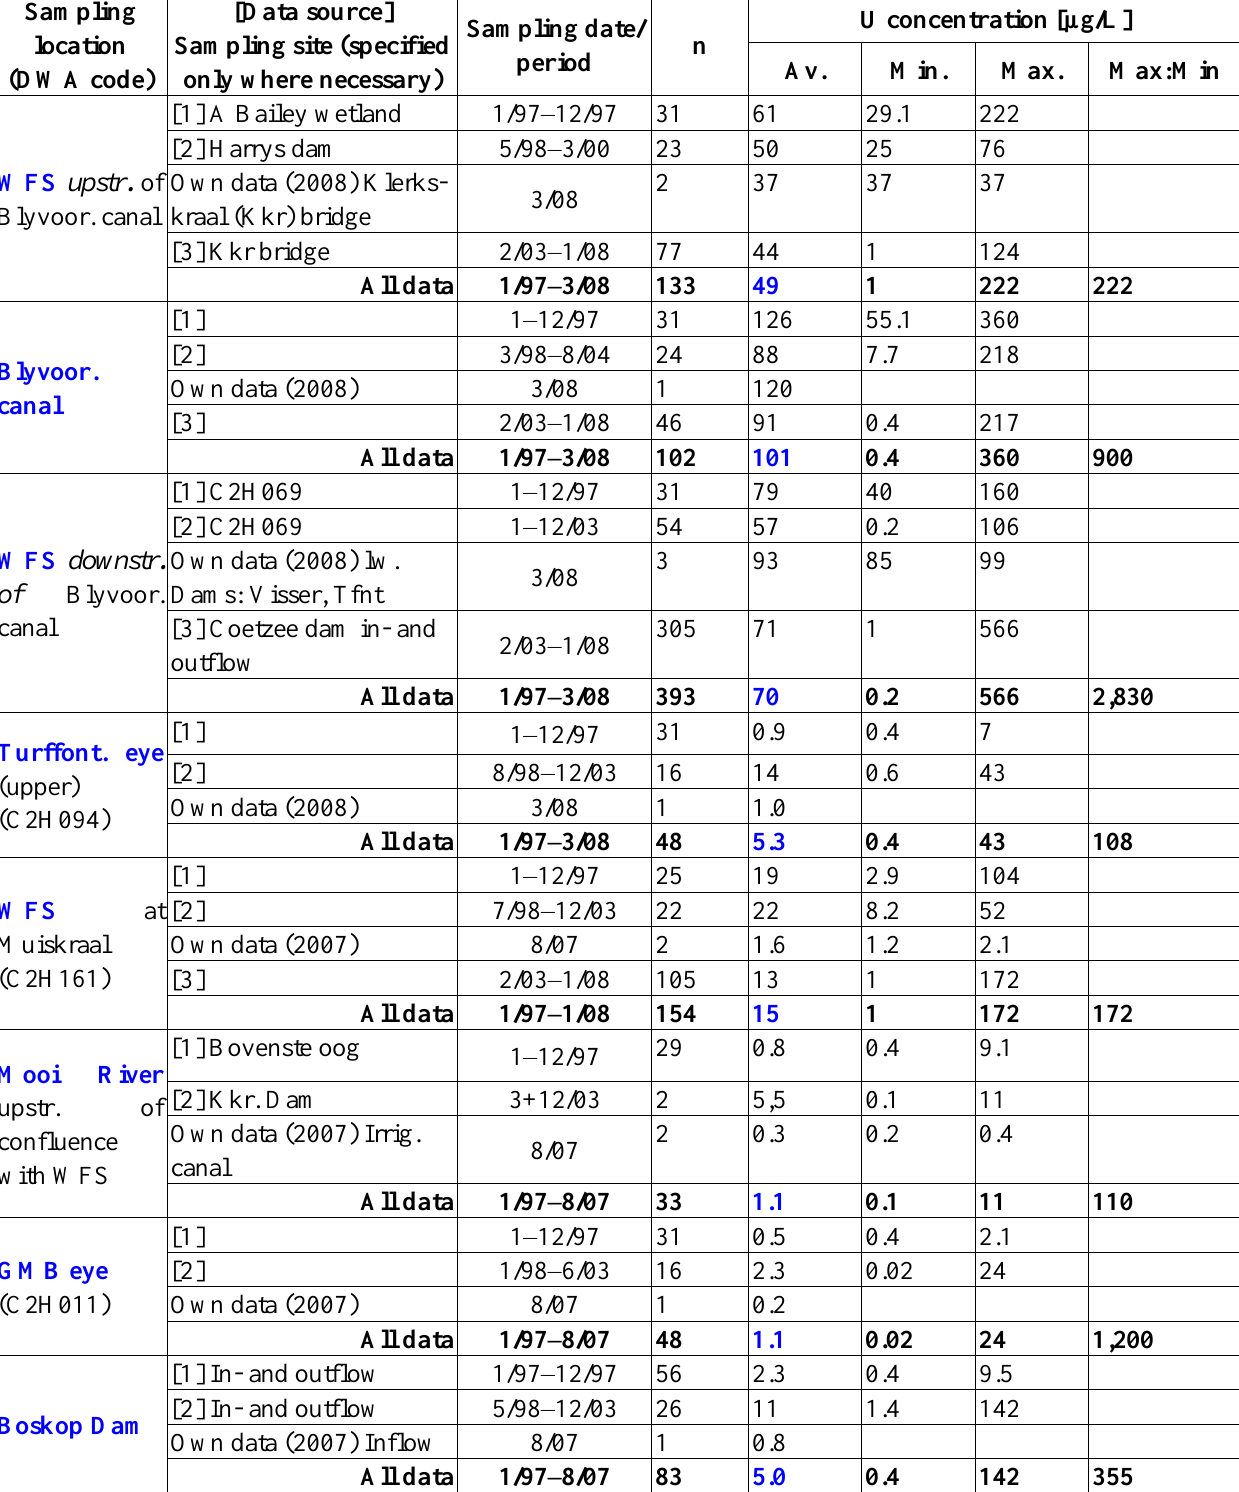
Table 1. Uranium (U) concentrations in stream water of the Wonderfonteinspruit (WFS), Mooi River and groundwater from the Boskop-Turffontein Compartment as found in a screening survey (‘own data’) in comparison to other studies (n—number of samples; av.—average weighted according to underlying number of samples; min.—minimum,